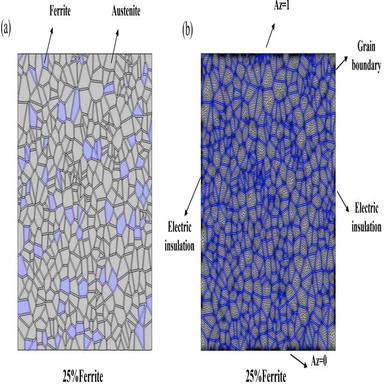
(a) Geometry of the model with 25% ferrite, (b) grid division diagram and magnetic field setting of the model.